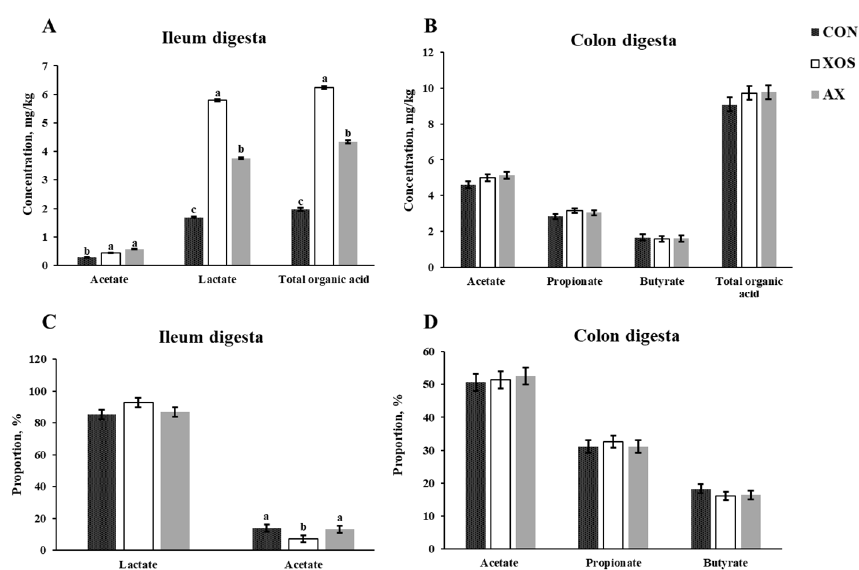
Figure 6. Effects of xylo-oligosaccharides and arabinoxylans on content of organic acids in the intestine of weaned pigs. Note: ( A ) ileum digesta; ( B ) colon digesta; ( C ) ileum digesta; ( D ) colon digesta. a–c Significant differences ( p < 0.05) between different letters in the same row of shoulder labels (n = 6); CON, a control diet; XOS, a diet containing 1% xylo-oligosaccharide; AX, a diet containing 1% arabinoxylans; SEM, standard error of the mean.